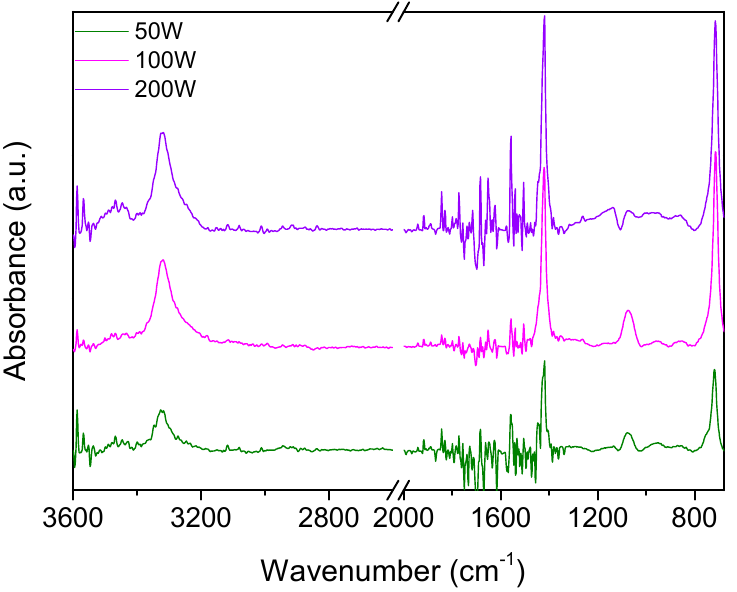
Figure 7. IR spectra of films deposited from compound 27 at variable plasma powers (50–200